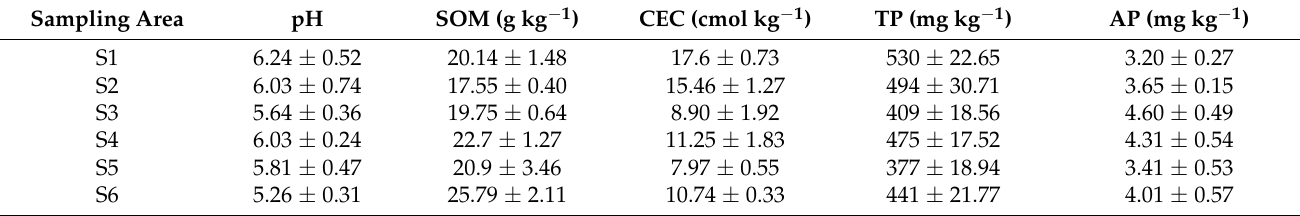
Table 1. Soil physicochemical properties.